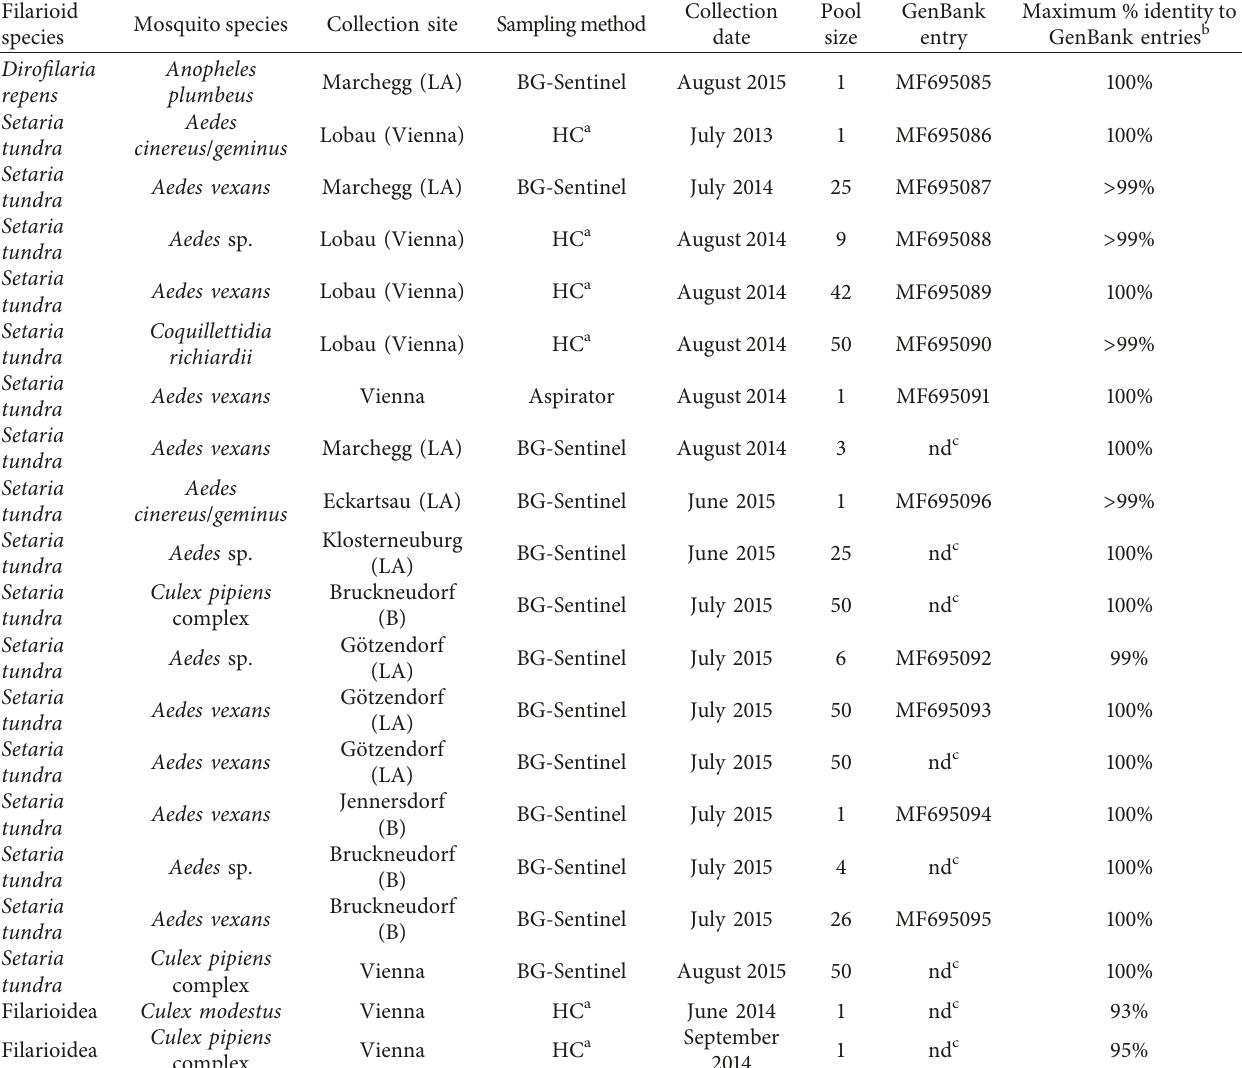
Table 2: Filarioid helminths in mosquitoes in Eastern Austria: Vienna, Lower Austria (LA), and Burgenland (B).